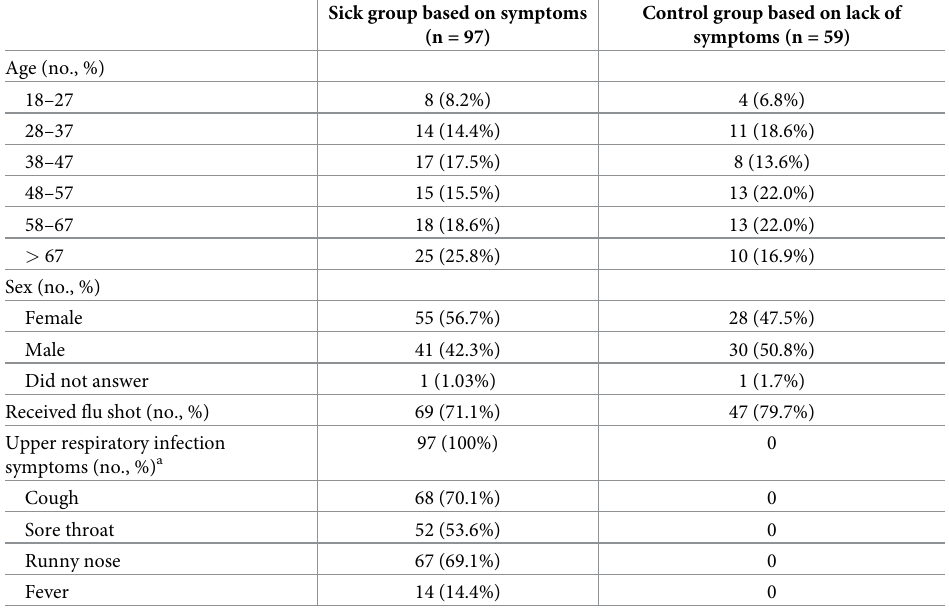
Table 1. Demographic and clinical characteristics of the 156 individuals sampled, split into sick and control (non- sick) groups.